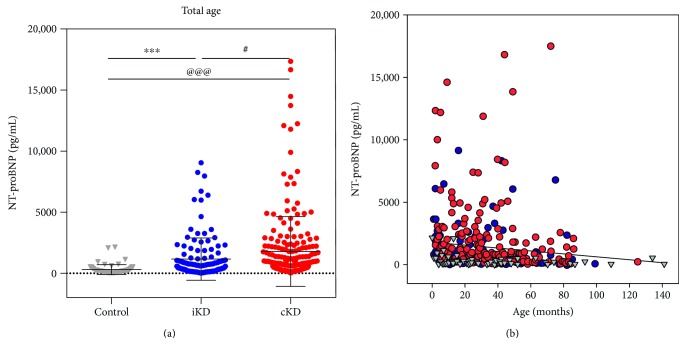
Dot plots of N-terminal prohormone of brain natriuretic peptide (NT-proBNP) in patients with complete Kawasaki disease (cKD), incomplete KD (iKD), and febrile illness (control) (a). NT-proBNP values by age (b). Black solid line depicts linear regression. #P < 0.05. ∗∗∗ and @@@P < 0.001.